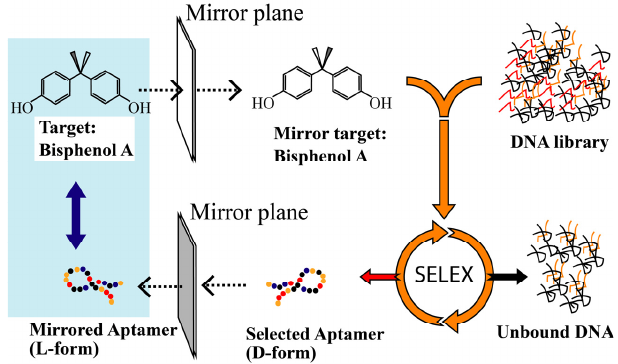
Figure 1. Illustration of the generation of a spiegelmer against the target. In the first step, a mirror- image form of the natural target is chemically synthesized (the original target is converted into a mirror-image target). Then, D-aptamers that bind to the mirror-image selection target are identified by in vitro selection from a synthetic oligonucleotide library in the natural D -configuration. The nat- ural D -configuration is required because stereoselective enzymes are used for amplification, cloning and sequencing of bound sequences. In the second step, the enriched D-form library is sequenced, and the identified sequences are synthesized using enantiomeric L-oligonucleotides. If the princi- ples of chirality are followed, the resulting L-aptamers (spiegelmers) will bind to the original natural target.